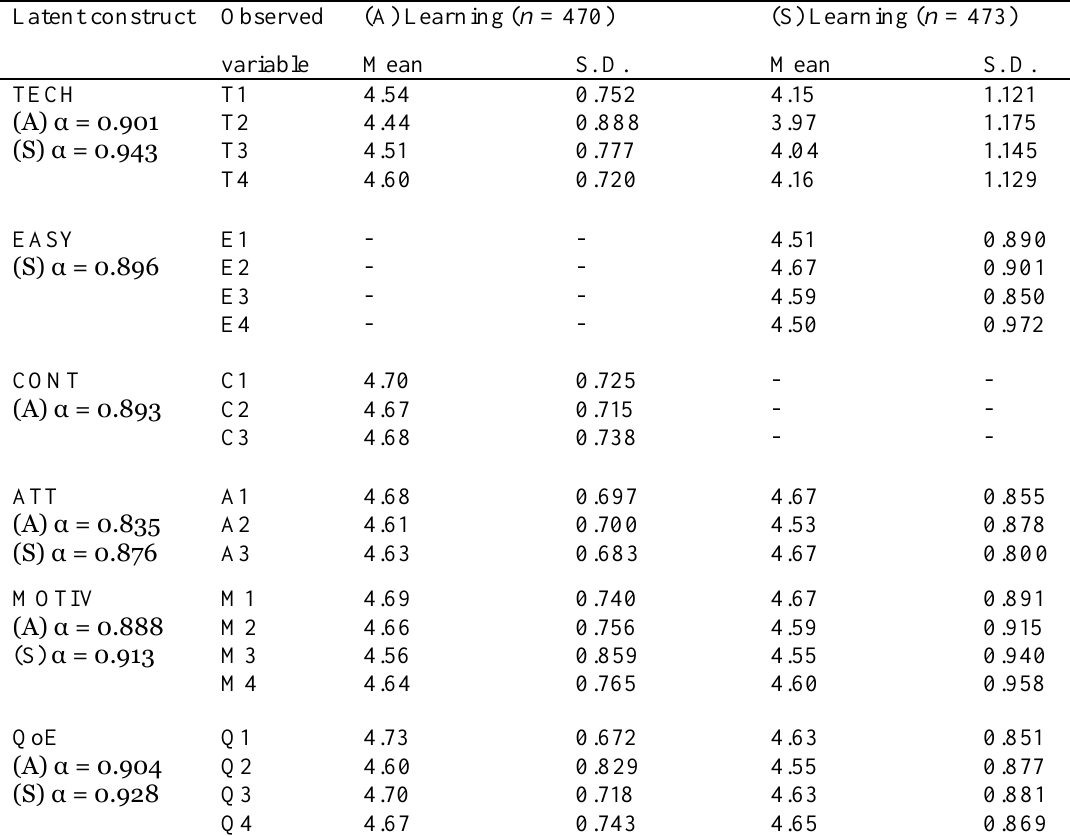
Descriptive Statistics for the Observed Variables and Reliability of